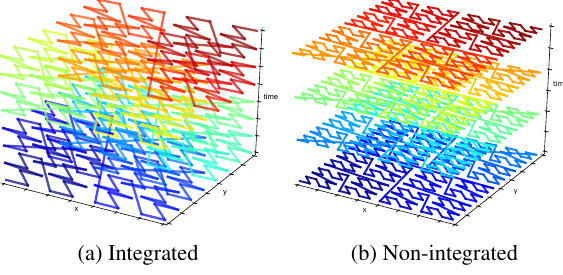
Figure 2: The two integrations of space and time.